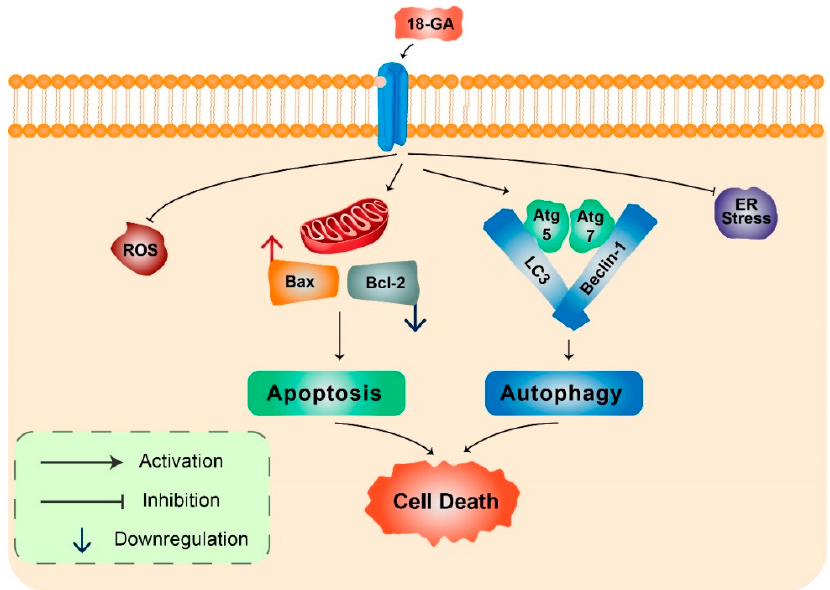
Figure 4. 18 α -Glycyrrhetinic acid-mediated cell death in human neuroblastoma cells. 18-GA induces mitochondria-mediated apoptosis to alter mitochondrial membrane potential in a significant change in with Bax/Bcl-2 ratio. Autophagy-related proteins Atg5/7, Beclin-1, LC3, and p62 were activated during 18-GA-mediated autophagic cell death. Beclin-1 contributes to autophagy in addition to apoptosis induction in 18-GA-mediated cell death. Additionally, ROS and ER stress showed no changes during 18-GA treatment in SH-SY5Y and B103.